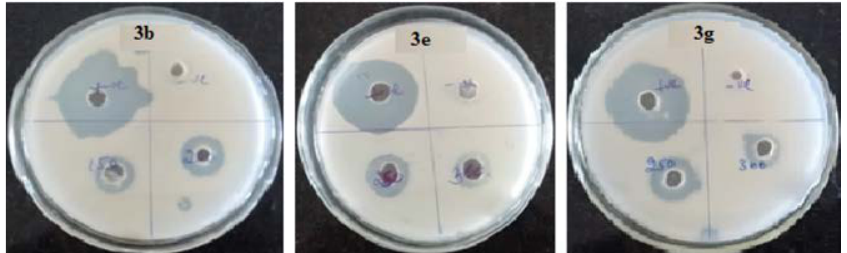
Figure 8. Photographs showing antifungal activity of the formamides (3b, 3e and 3g) in agar well diffusion method with Humicolafuscoatra